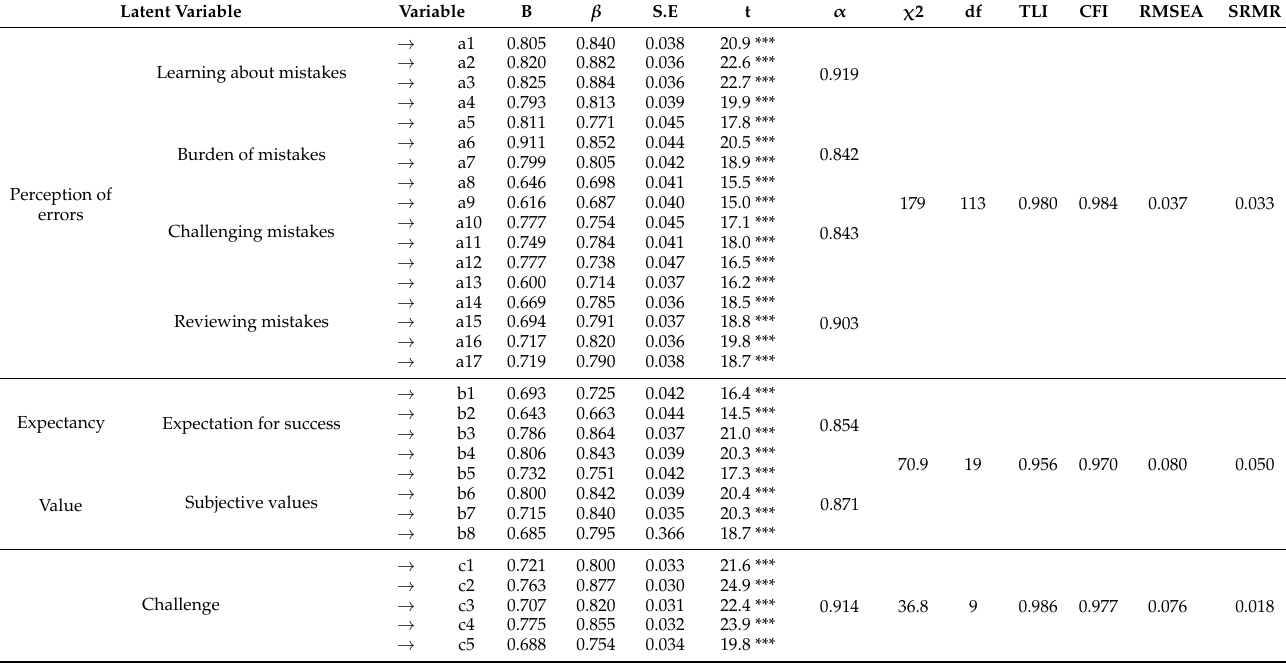
Table 2. Confirmatory factor analysis and reliability analysis of perception of errors, expectancy value, and